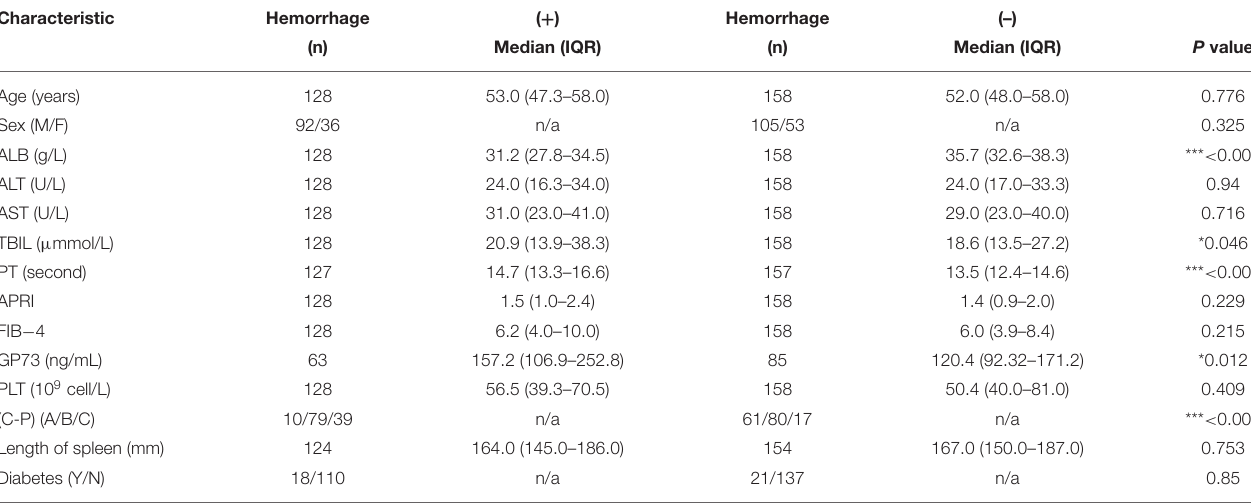
TABLE 2 | Comparisons between patients with and without esophageal variceal hemorrhage. Characteristic